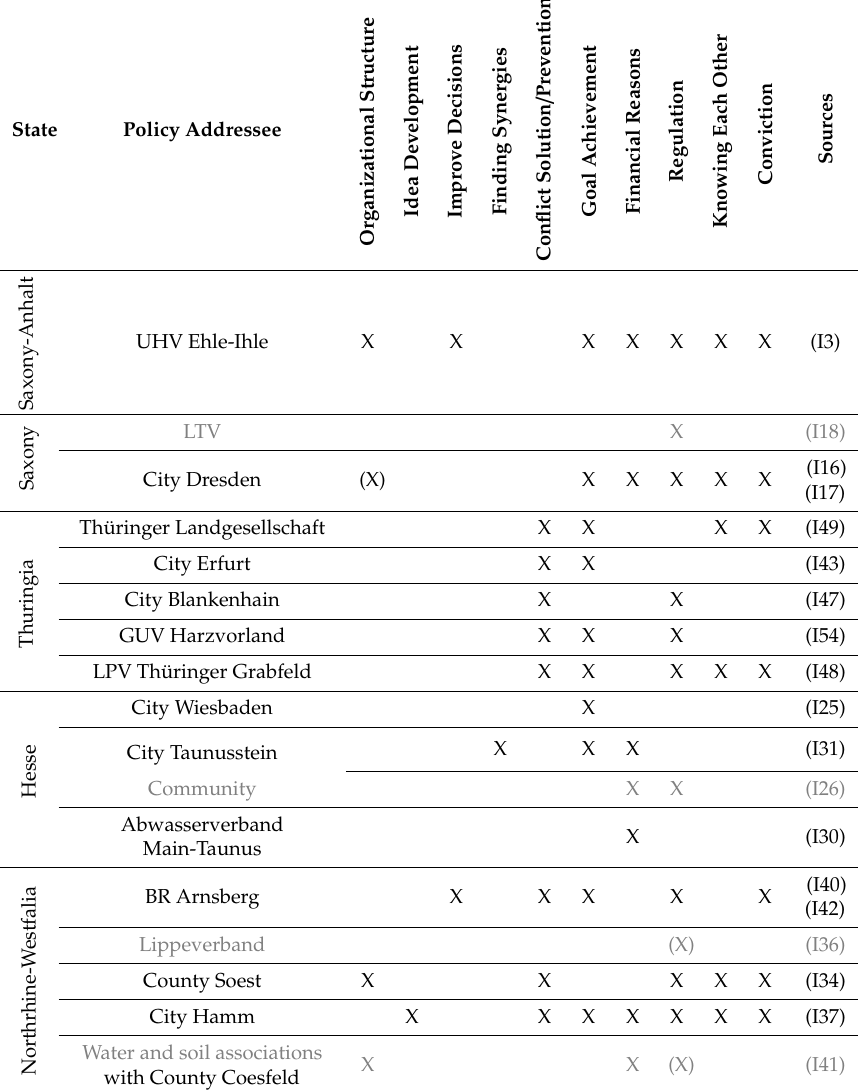
Table 4. Drivers to adopt integrative